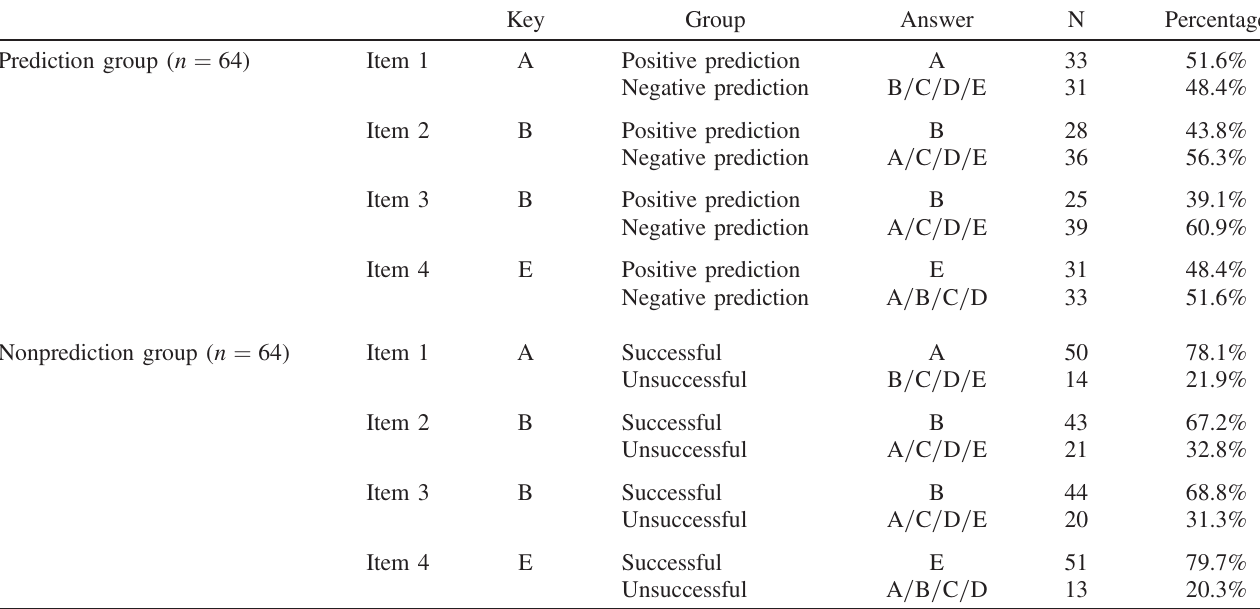
TABLE I. Description of preservice teachers ’ outcome on each item for both